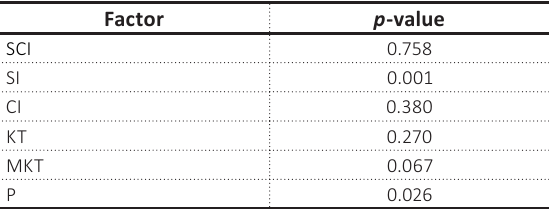
Table 5. ANOVA test of study factors Factor p